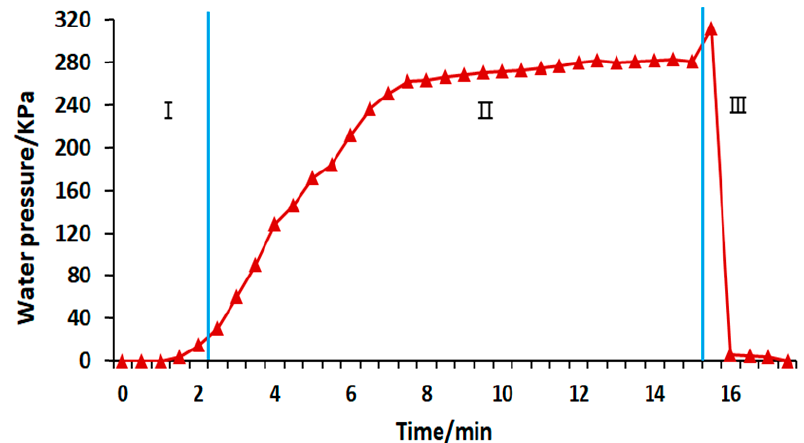
Figure 13. Water pressure variation of aquifuge rock in the process of water inrush of cavity in front of the tunnel face.